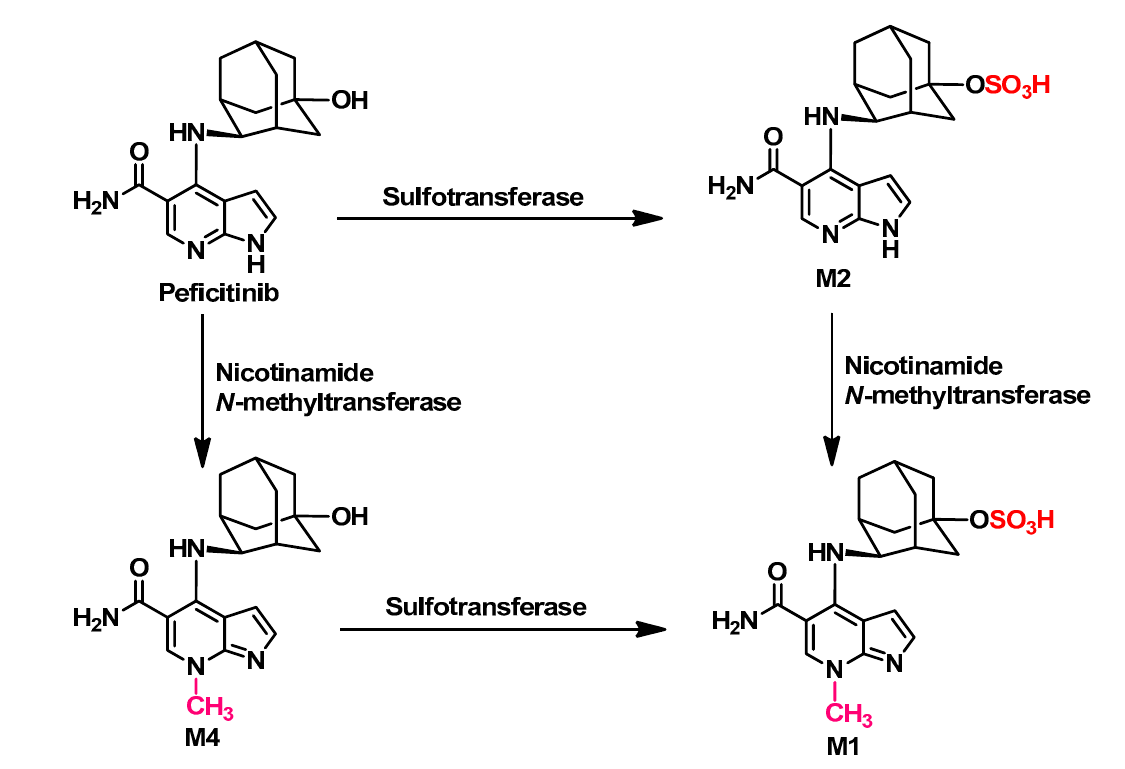
Figure 49. Proposed metabolic pathways and metabolites of peficitinib.